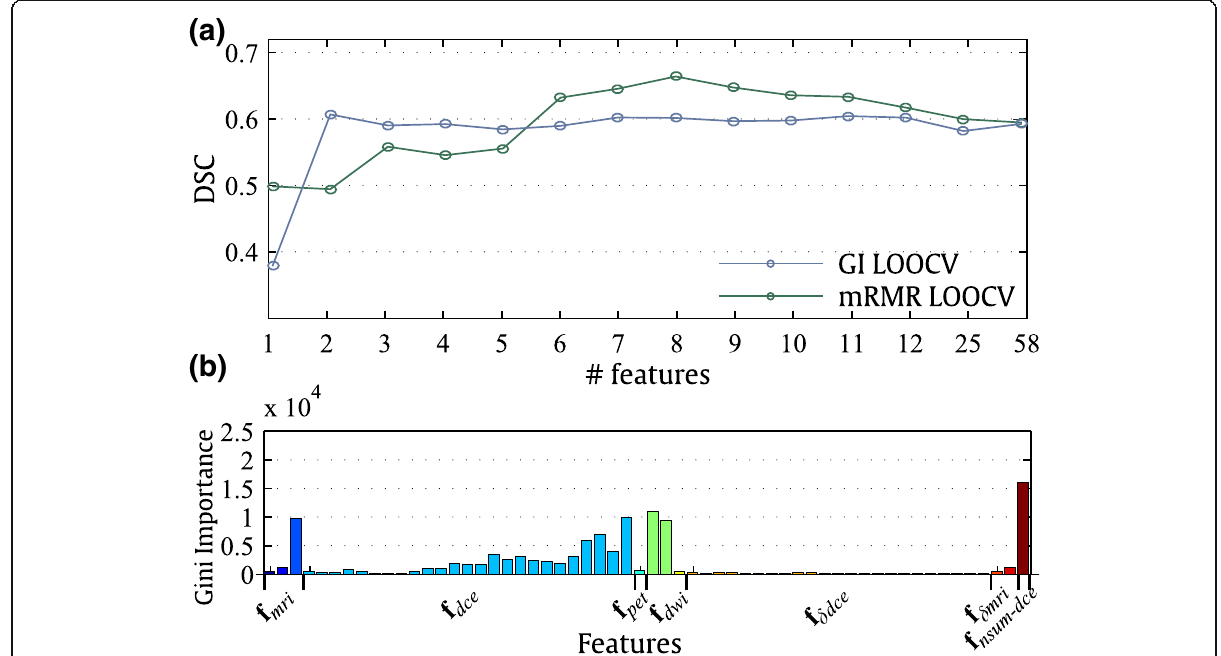
Fig. 5 Feature ranking and its influence on segmentation performance. a The mean DSC, using a successively increasing number of top-ranked features according to RF GI and mRMR ranking. b GI feature ranking of the segmentation features. The four top-ranked features are labelled in the figure